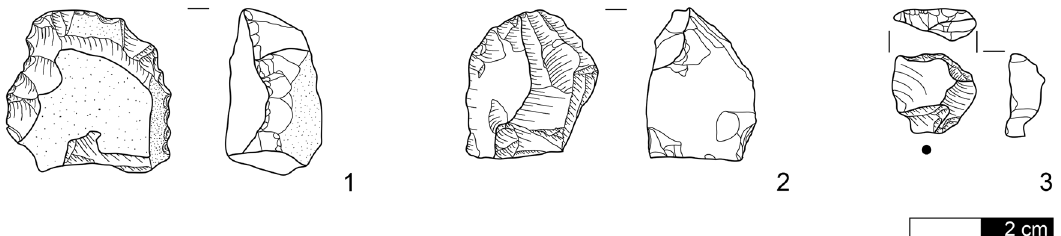
Figure 10: Three scrapers ( 1 – 3 ) from the site Bäramähder ( Posch & Leitner, 2019 )